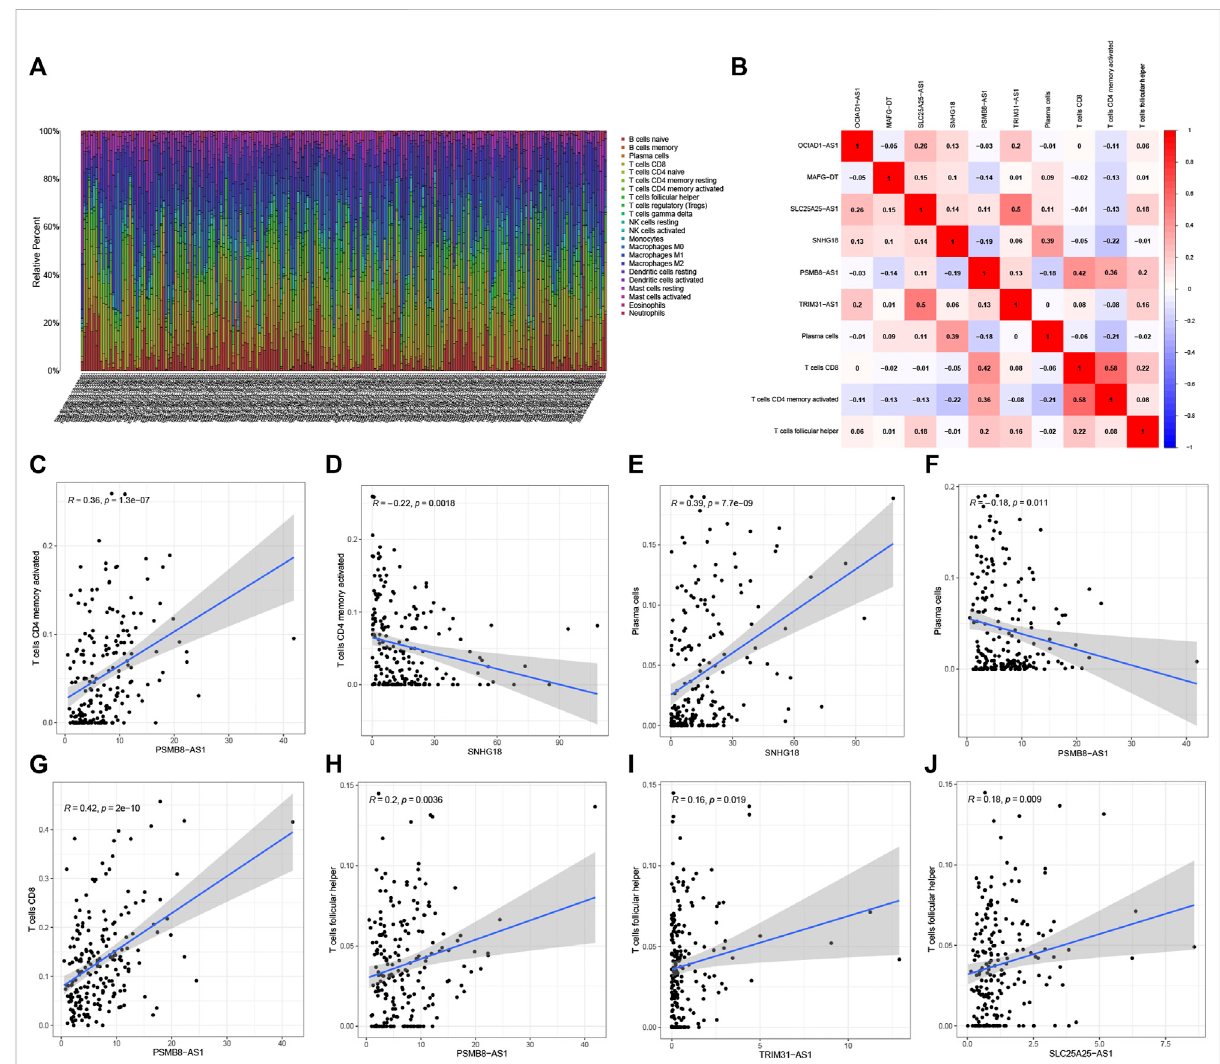
FIGURE 9 Correlationanalysisof6PRLsandimmunity. (A) Thein fi ltrationdegreesofimmunecellsinBCsamples. (B) Heatmapre fl ectedthedistributionof the6PRLsandimmunecells. (C,D) :TherewasapositivecorrelationbetweenTcellsCD4memoryactivatedandlncRNAPSMB8-ASI,whiletherewas anegativecorrelationbetweenTcellsCD4 memoryactivatedandlncRNAsSNHG18. (E,F) :Plasmacellscontainedapositive correlationwithlncRNA SNHG18 and negative correlation with lncRNA PSMB8-ASI. (G) T cells CD8 involved a positive correlation with lncRNA PSMB8-ASI. (H – J) : T cells follicular helper and 3 lncRNAs (PSMB8-ASI, TRIM31-AS1and SLC25A25-AS1) presented a positive correlation